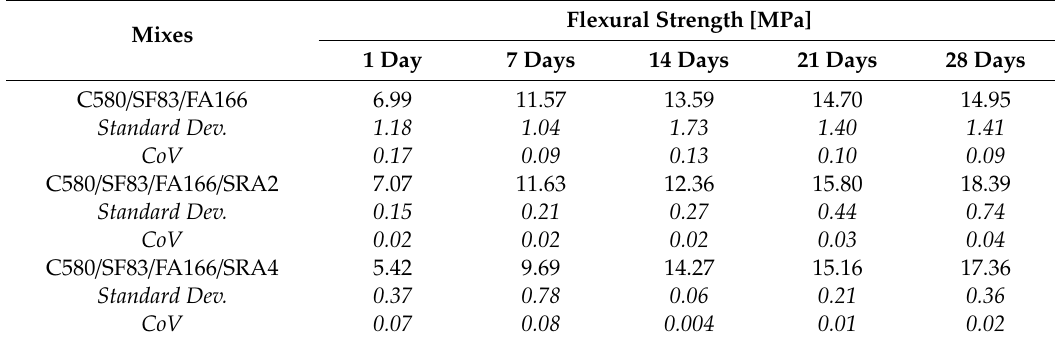
Table 3. Flexural strength.